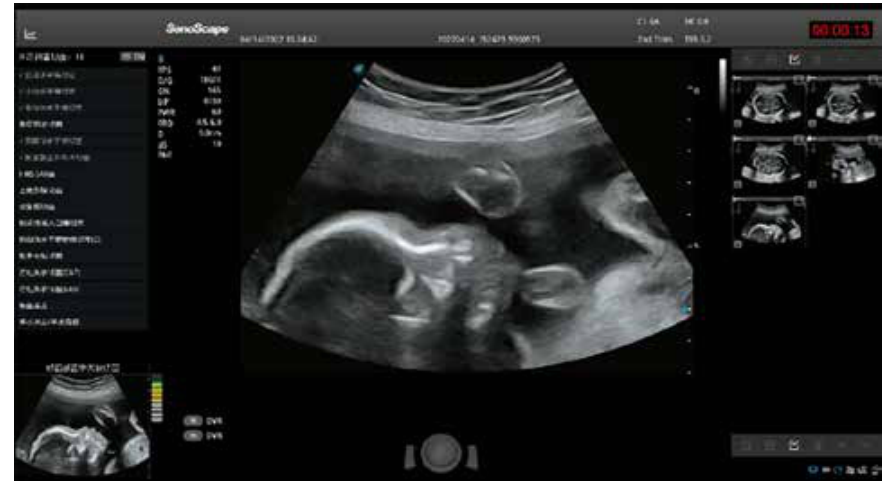
Figure 4 The quality score of the captured image is displayed in real time by a color strip in the lower-left corner of the ultrasound display